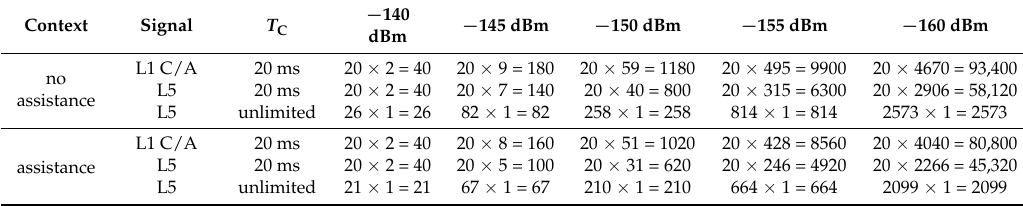
Table 6. Total integration time T IT = T C × N NC as function of the sensitivity and context with GPS signals, for worst losses. Note that the sensitivities given are for the L1 C/A signal; those of L5 are 1.5 dB higher.